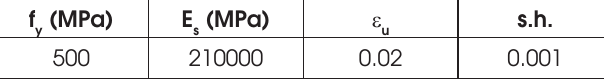
Steel properties used for the design